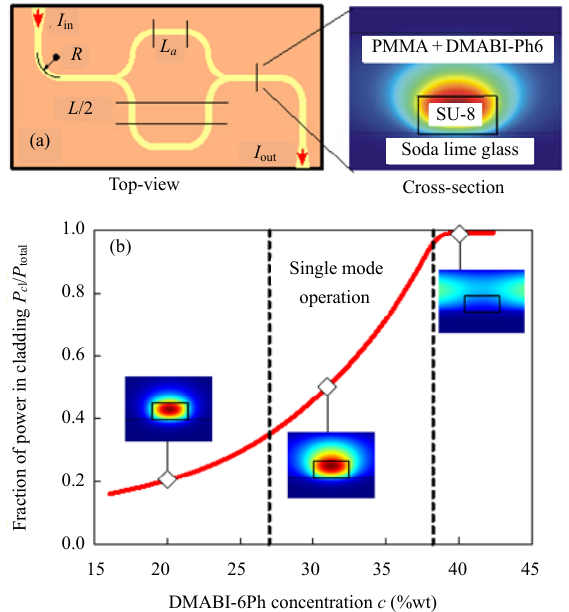
Fig. 1 Waveguide sensor device design and optical mode simulations: (a) the top-view and cross-section of the waveguide MZI, where I in and I out are the light input and output intensities, respectively; I 1 and I 2 are the light intensities in the MZI arms, R = 500 μ m is the bend radius of the waveguide, and L = 8 mm is the MZI arm excess length. The waveguide core is made of SU-8 and has the width of 1.5 μ m and the height of 0.7 μ m. The cladding is a 1.2- μ m-thick organic glass PMMA + DMABI-Ph6. The cross-section image also holds the calculated mode profile and (b) fraction of mode power in the cladding as a function of DMABI-Ph6 concentration c . Single mode operation is ensured when DMABI-Ph6 concentration is in the range from 27 wt% to 38